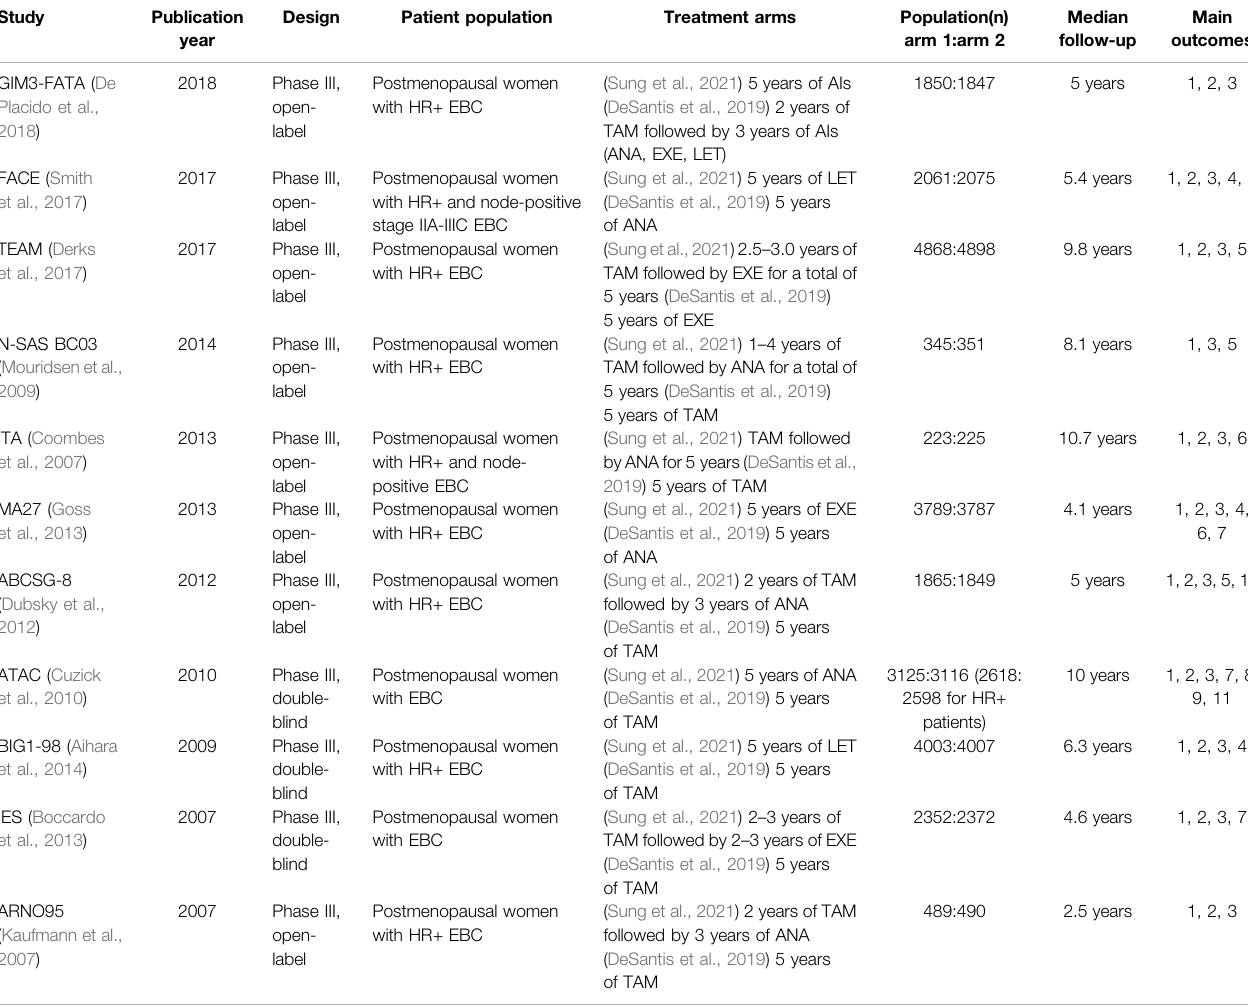
TABLE 1 | Basic characteristics of included